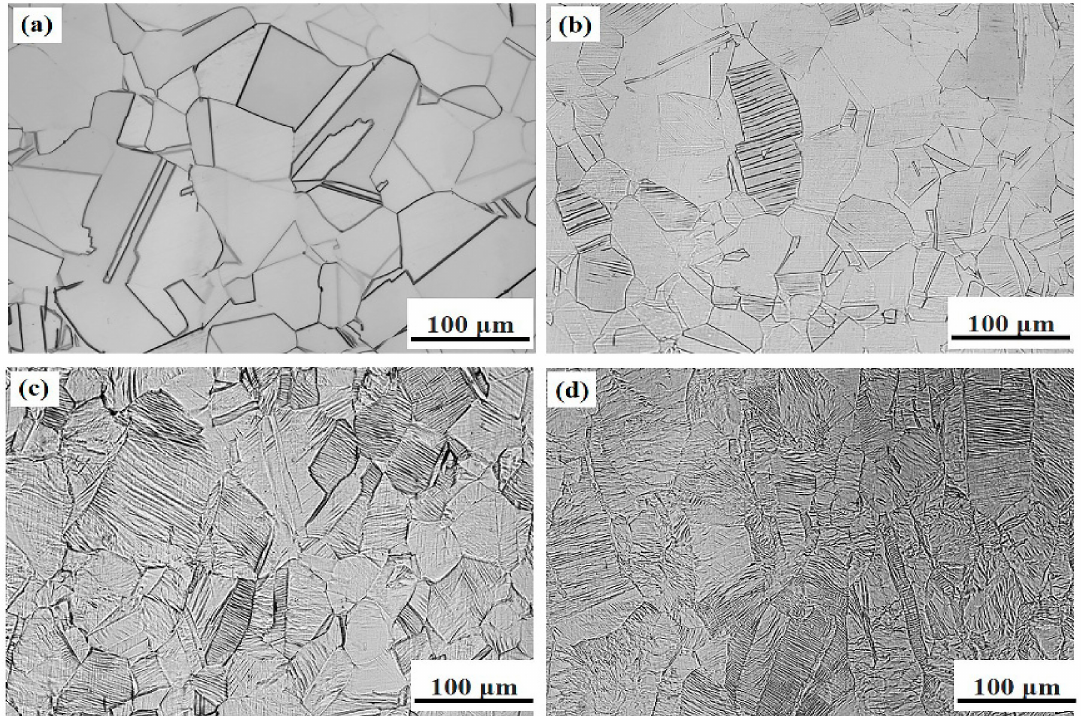
Figure 1. Optical micrographs showing the microstructure of specimens with different warm rolling reductions ( a ) 0%, ( b ) 20%, ( c ) 35%, ( d )